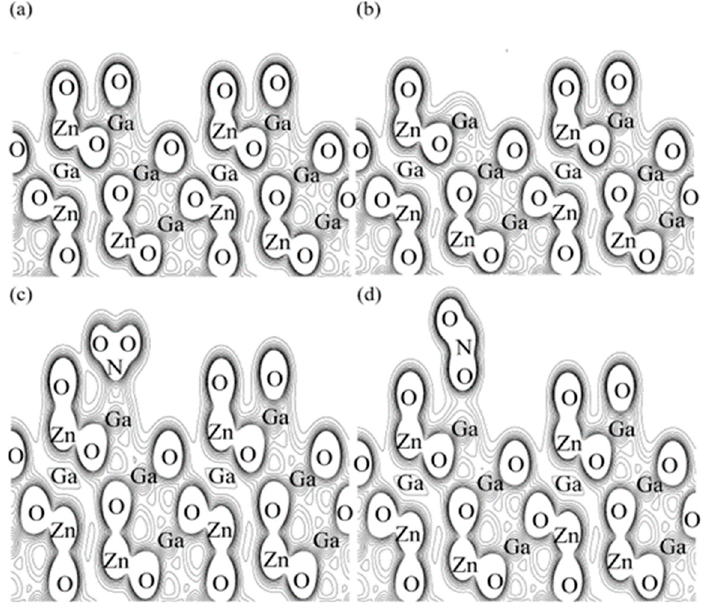
Figure 11. Valence charge density maps on ( a ) the oxide-passivation ZGO surface, ( b ) the oxide- passivation ZGO surface with one surface oxygen removed, ( c , d ) NO 2 -like molecules on the oxide- passivation ZGO surface. The charge is normalized to 36 electrons per unit slab. The contours are plotted in a range from 0.038 to 0.418 electrons Å − 3 in 10 steps.